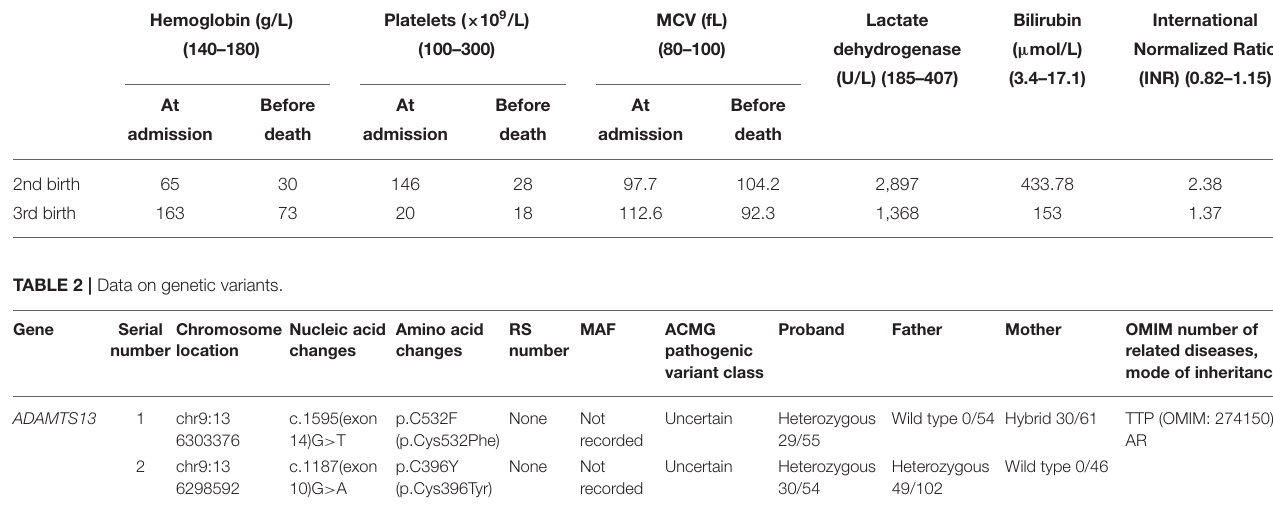
TABLE 3 | Clinical features and prognoses of 12 neonates with congenital TTP. Case Sex Time of number